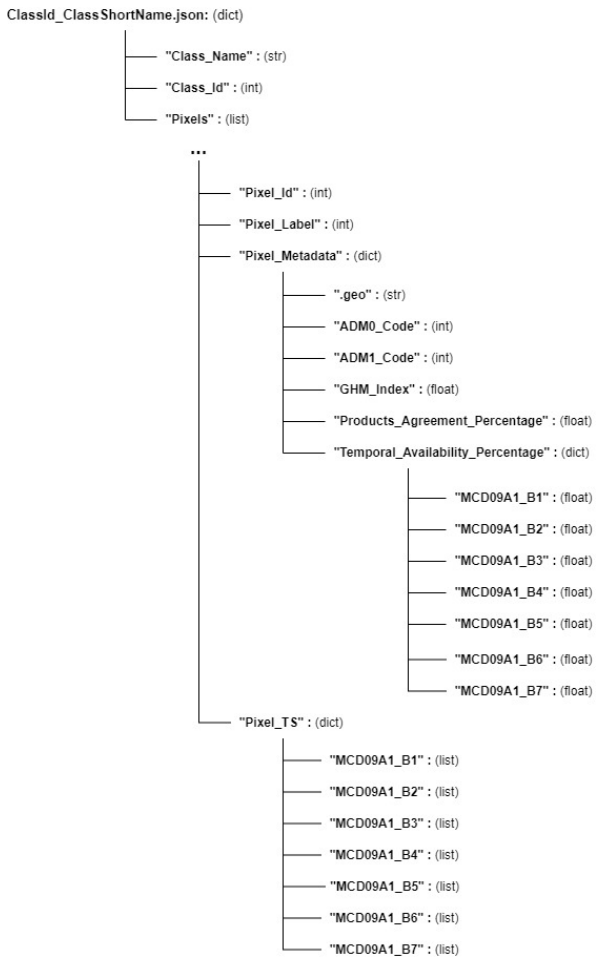
Figure 9. Data structure of an LULC class JSON file for the bal- anced subset of the original